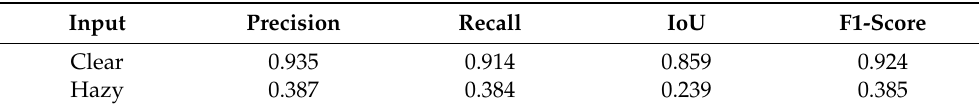
Table 5. Quantitative comparisons of D-LinkNet road extraction accuracy using clear images and hazy images.